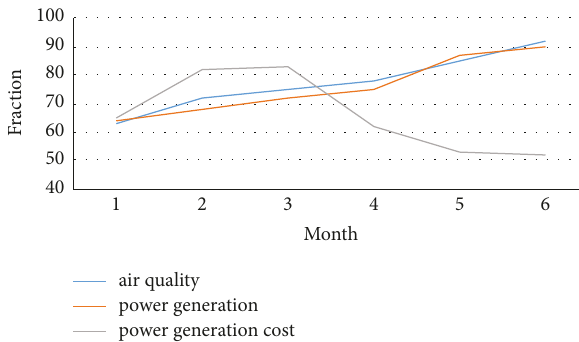
Figure 8: Changes in monthly air quality, power generation, and power generation costs in region C. Figure 6: Changes in monthly air quality, power generation, and